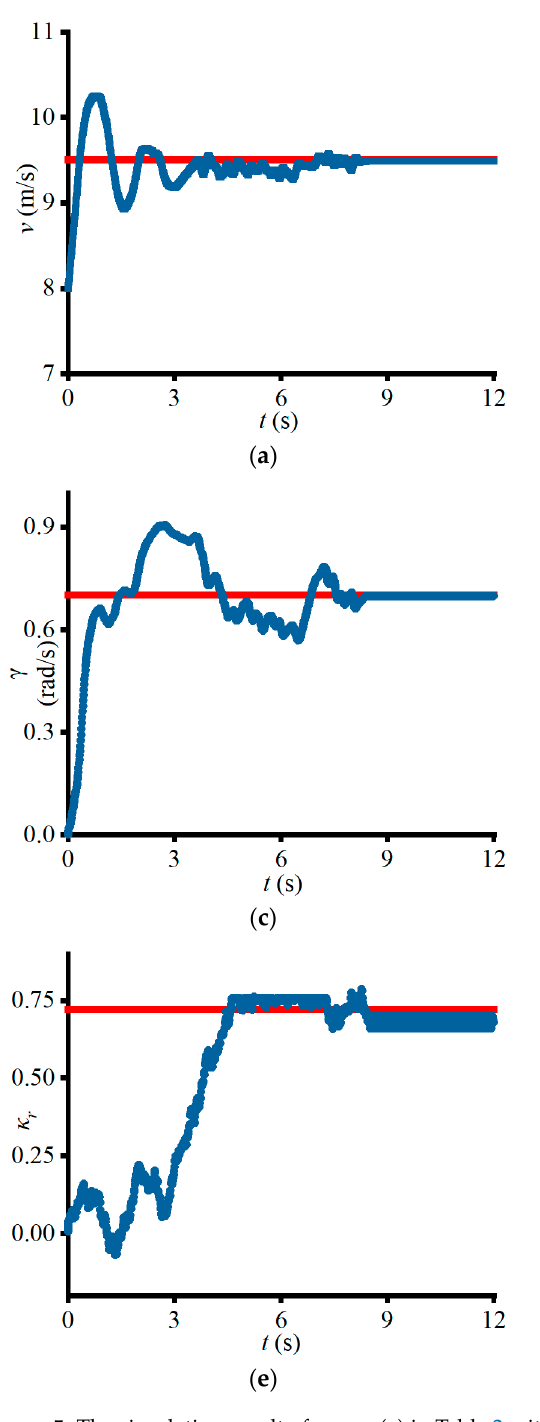
Figure 5. The simulation result of group (a) in Table 2 with the origin uniform linear: ( a ) The variation curve of the velocity; ( b ) the variation cure of the sideslip angle; ( c ) the variation curve of the yaw rate; ( d ) the variation cure of the steering angle; ( e ) the variation curve of the TYDEX longitudinal slip ratio of the rear tire; and ( f ) the variation cure of the radius .